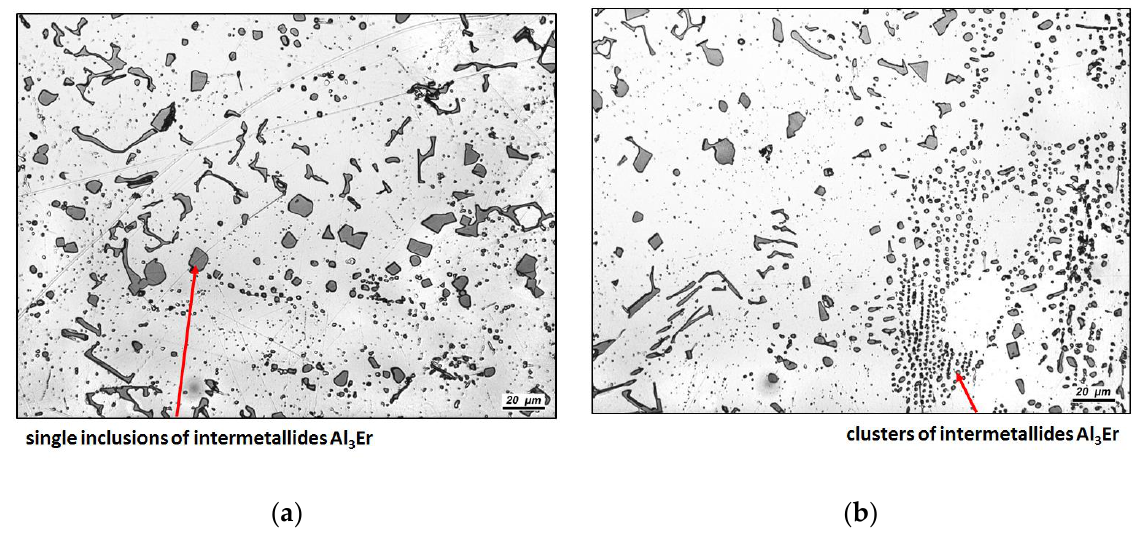
Figure 3. Microstructure of the master alloy composition Al-8Er: ( а ) ×500; ( b ) ×500.